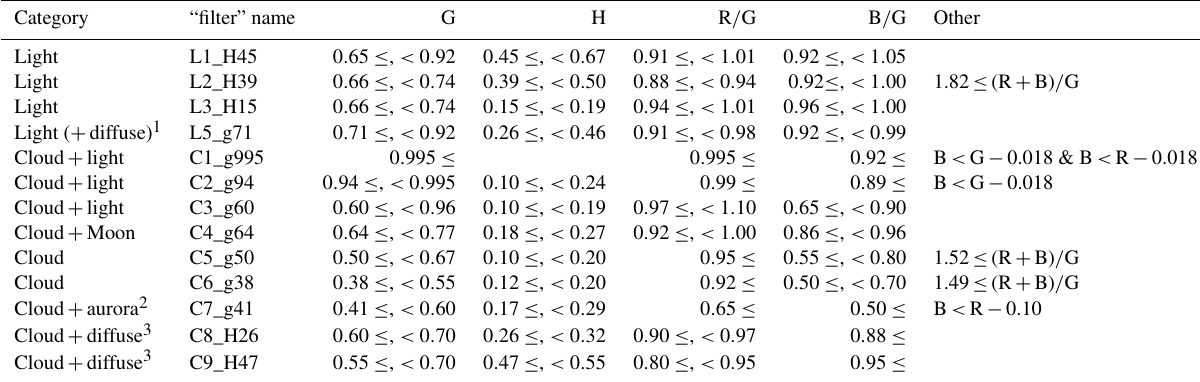
Table 4. Criteria of a pixel for artificial light (“light” in the first column) and cloud (the same format as Table 2). Category “filter”